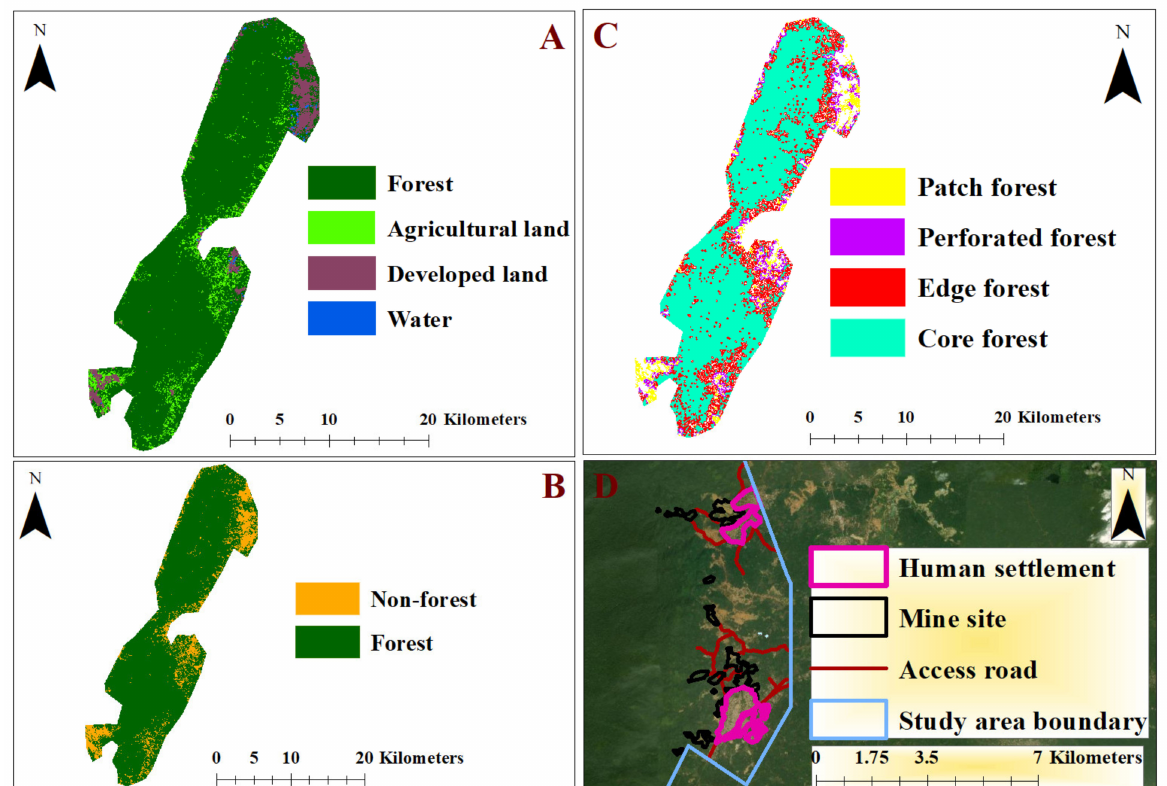
Figure 2. Classified Landsat image showing land categories and forest/non-forest patches. ( A ) shows the land classes, ( B ) shows the forest/non-forest patches, ( C ) shows the visual impression of the morphological analysis output indicating the categories of forest fragmentation and ( D ) shows locations of some of the land use footprints in the Atewa Range Forest